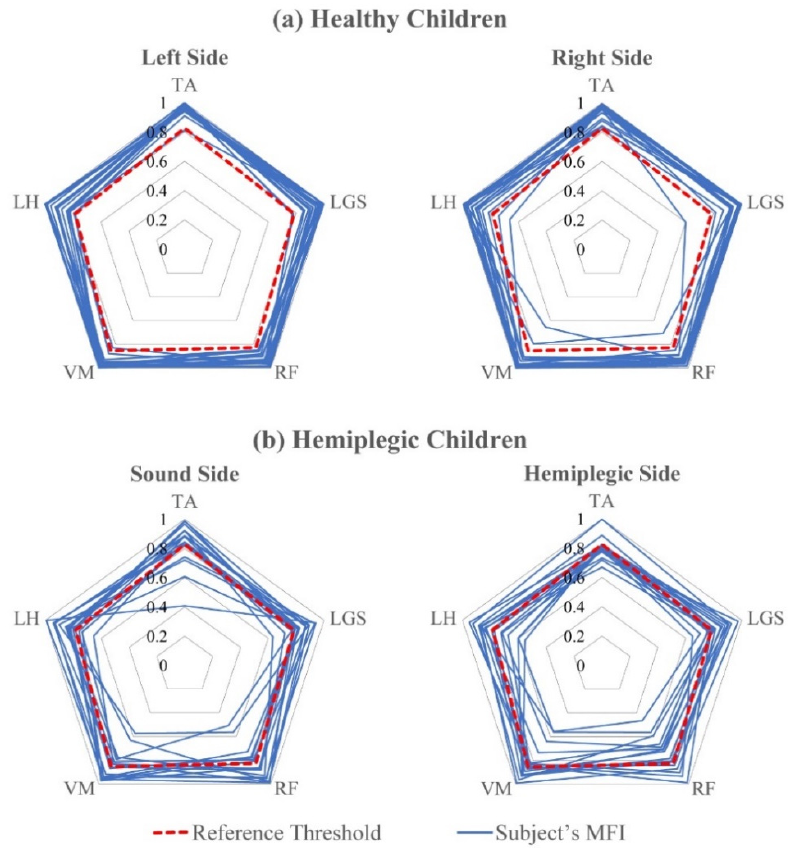
Figure 6. Radar diagram of MFI values for ( a ) the 18 healthy children and ( b ) the 16 hemiplegic children, both sides. The dotted red lines join the reference threshold R Th for each muscle. The blue lines join the MFI values for each subject in the two test groups. Muscles: Tibialis Anterior (TA), Gastrocnemius Lateralis (LGS), Vastus Medialis (VM), Rectus Femoris (RF), and Lateral Hamstring (LH).